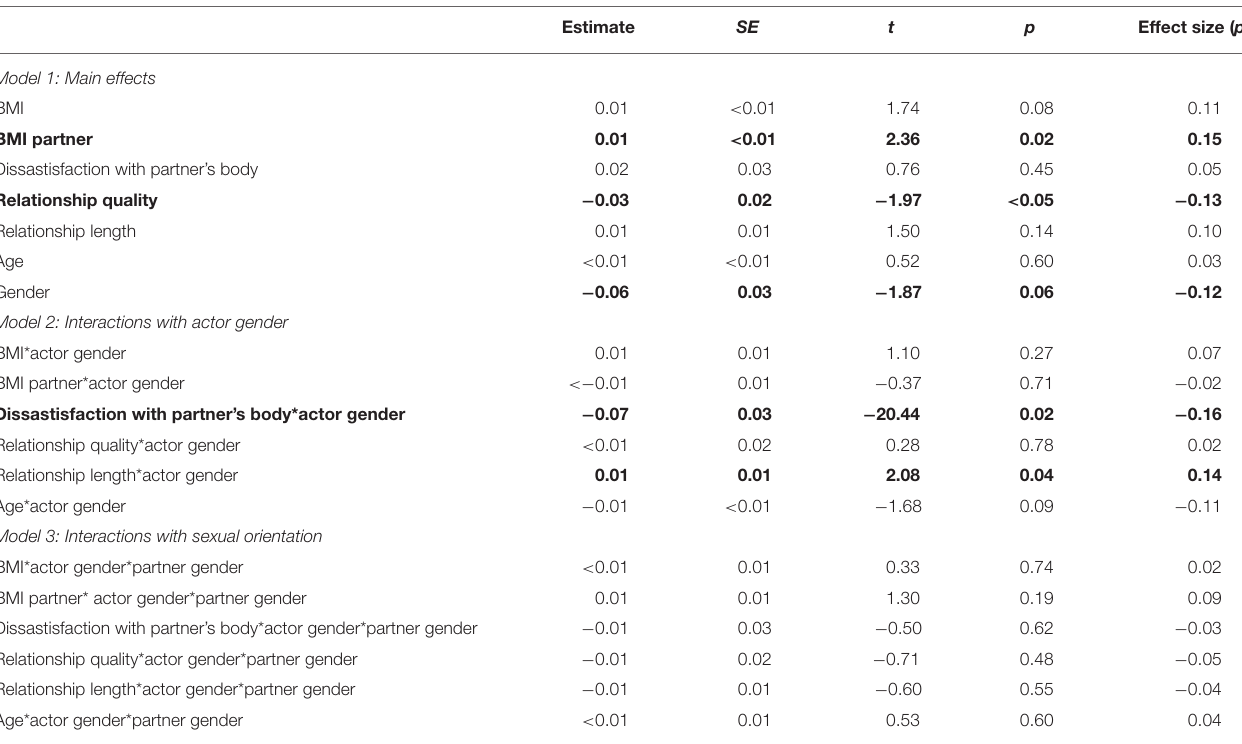
TABLE 3 | Multilevel models predicting participants’ perceptions of their partner’s weight change ( N = 500).